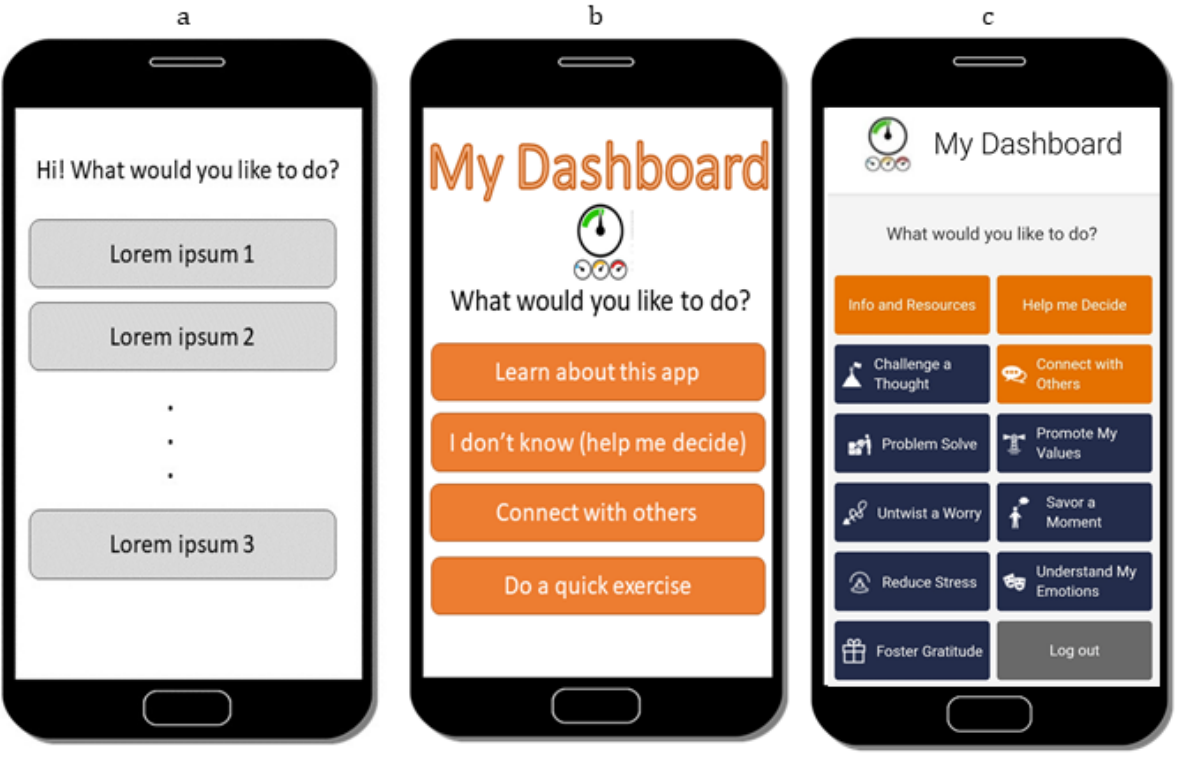
Figure 1. Examples of 2 previous wireframes for the iCanThrive main dashboard page using PowerPoint. From left to right: (a) early iteration sketch,